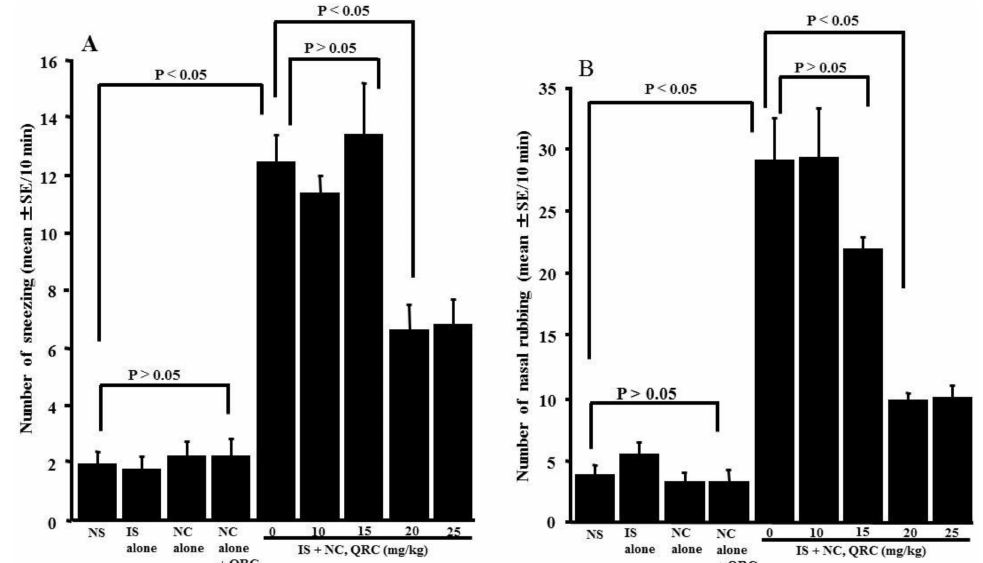
Figure 7. Influence of quercetin on the development of nasal allergy-like symptoms in OVA-sensitized mice after the OVA nasal challenge. BALB/c mice were sensitized by an intraperitoneal injection of OVA on days 0, 7, and 14. Seven days after the final sensitization, the OVA-sensitized mice were intranasally challenged with OVA on days 21, 23, and 25, and various concentrations of quercetin were administered orally once a day for five consecutive days. Nasal allergy-like symptoms, the number of sneezes ( A ), and nasal rubbing behaviors ( B ) were counted for 10 min immediately after the final nasal antigenic challenge. The data are expressed as the mean ± SE of five mice. NS: non-sensitized; IS: intraperitoneal sensitization; NC: nasal challenge alone; QRC: